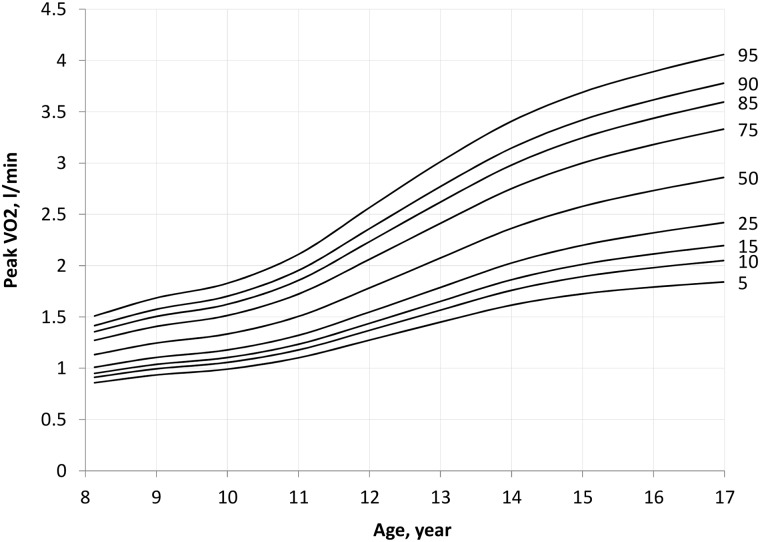
Percentile curves of peak VO2 (l·min-1) in boys.